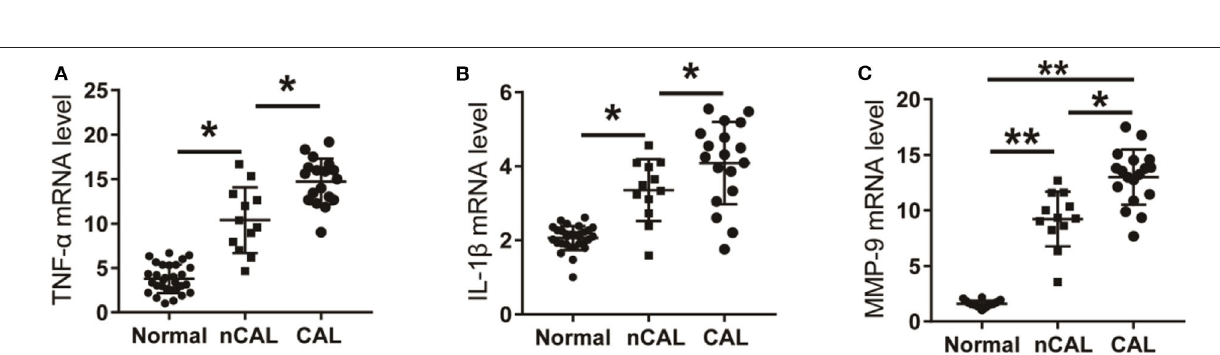
FIGURE 4 | The level of inflammatory factors in KD patients. (A) TNF- α in KD patients and control children. (B) IL-1 β in KD patients and control children. (C) MMP-9 in KD patients and control children. * P < 0.05; ** P < 0.01.